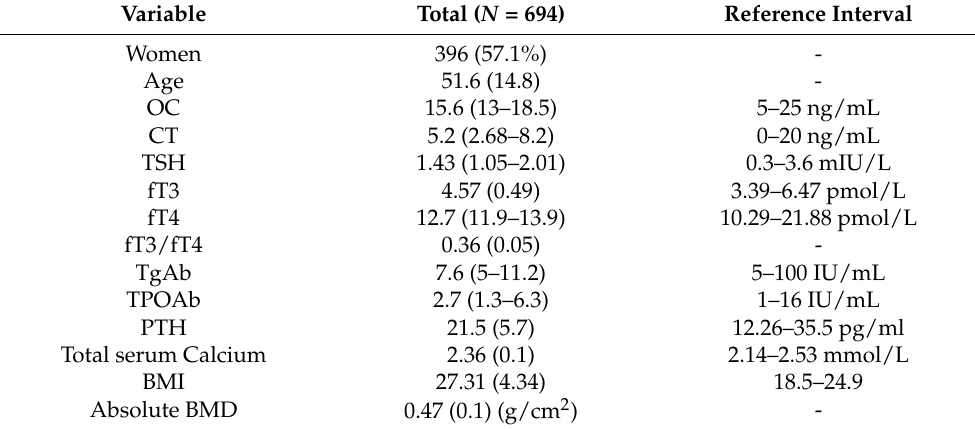
Table 1. Clinical characteristics of study participants.